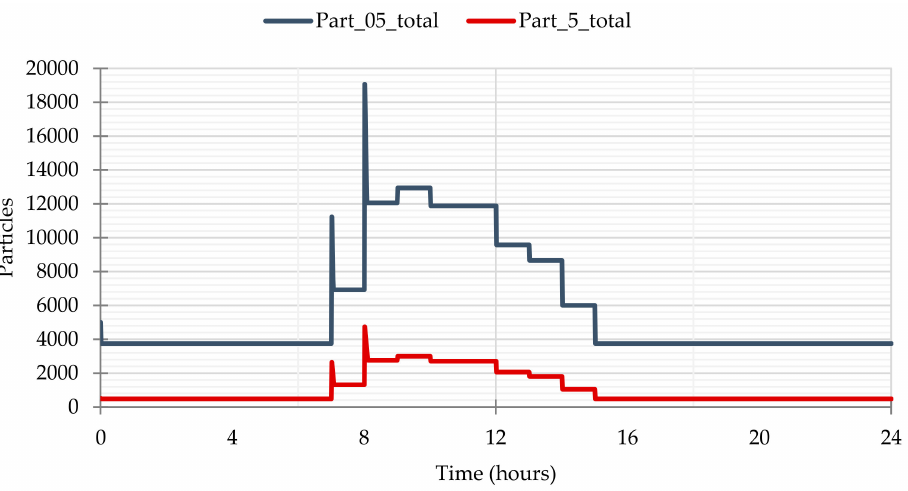
Figure 8. Simulation results during 24 h (Case